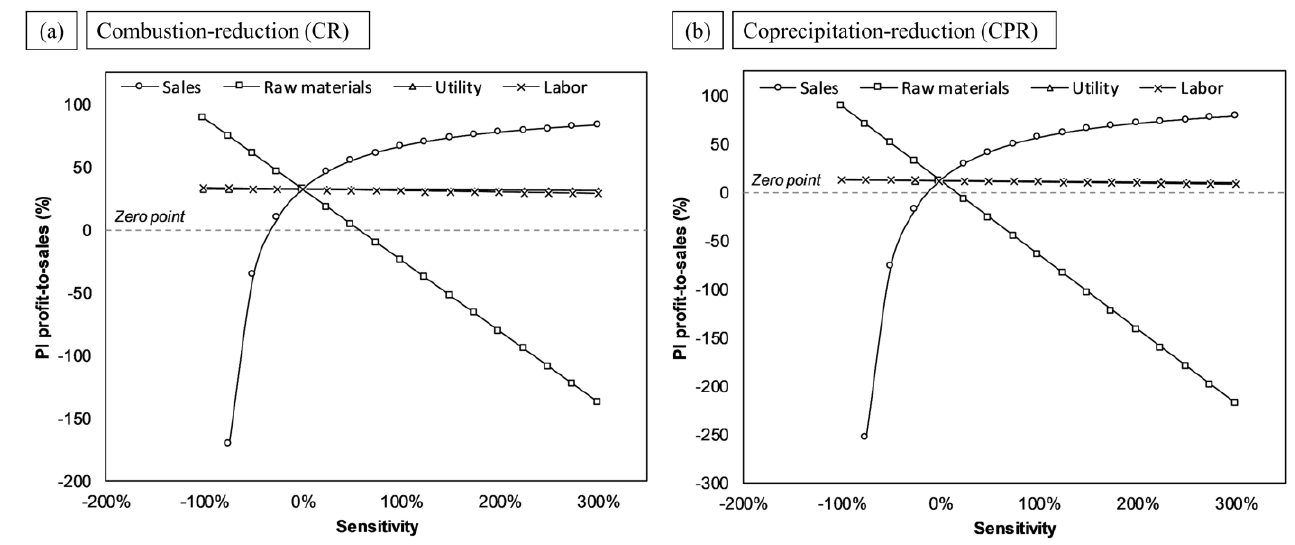
Fig. 6. Analysis of PI profit-to-sales as a function of sales, raw materials, utility, and labor for (a) combustion-reduction (CR) and (b) coprecipitation-reduction